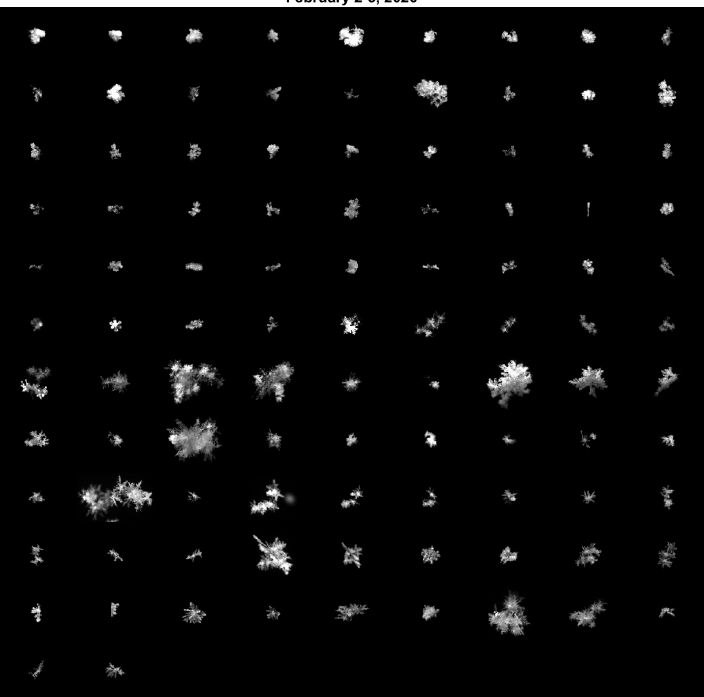
Figure C4. MASC imagery for 2 to 3 February